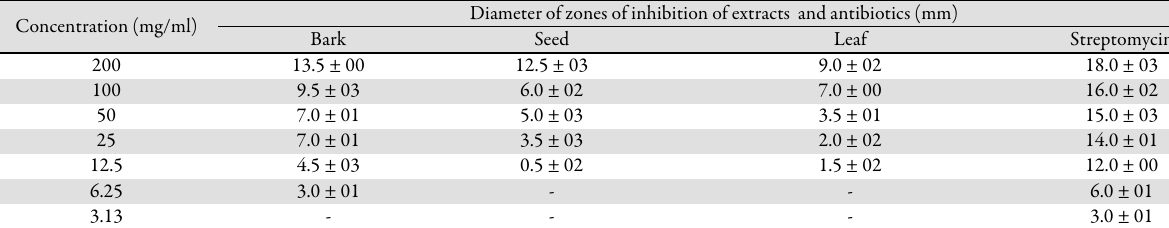
Phytochemical composition Table 1. General glycosides, tannins, saponins, carbohydrates, alkaloids and trepenoids were present in all plant parts (stem bark, root and leaf) of V. paradoxa ethanolic extracts. Steroids